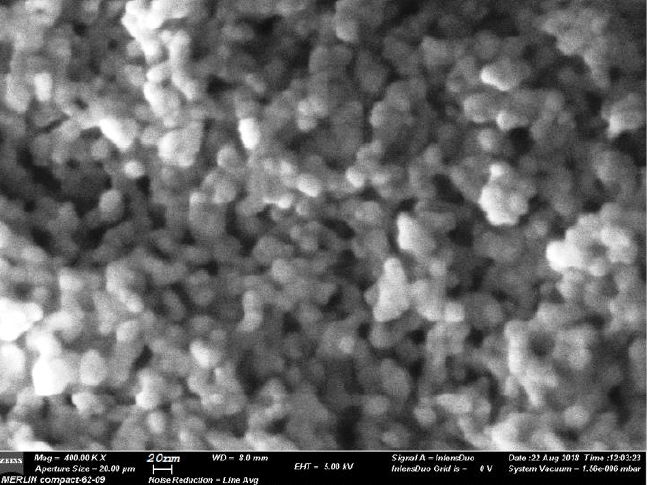
Figure 2. SEM image of CeF 3 :Tb nanocrystalline powder calcinated at 400 °C.